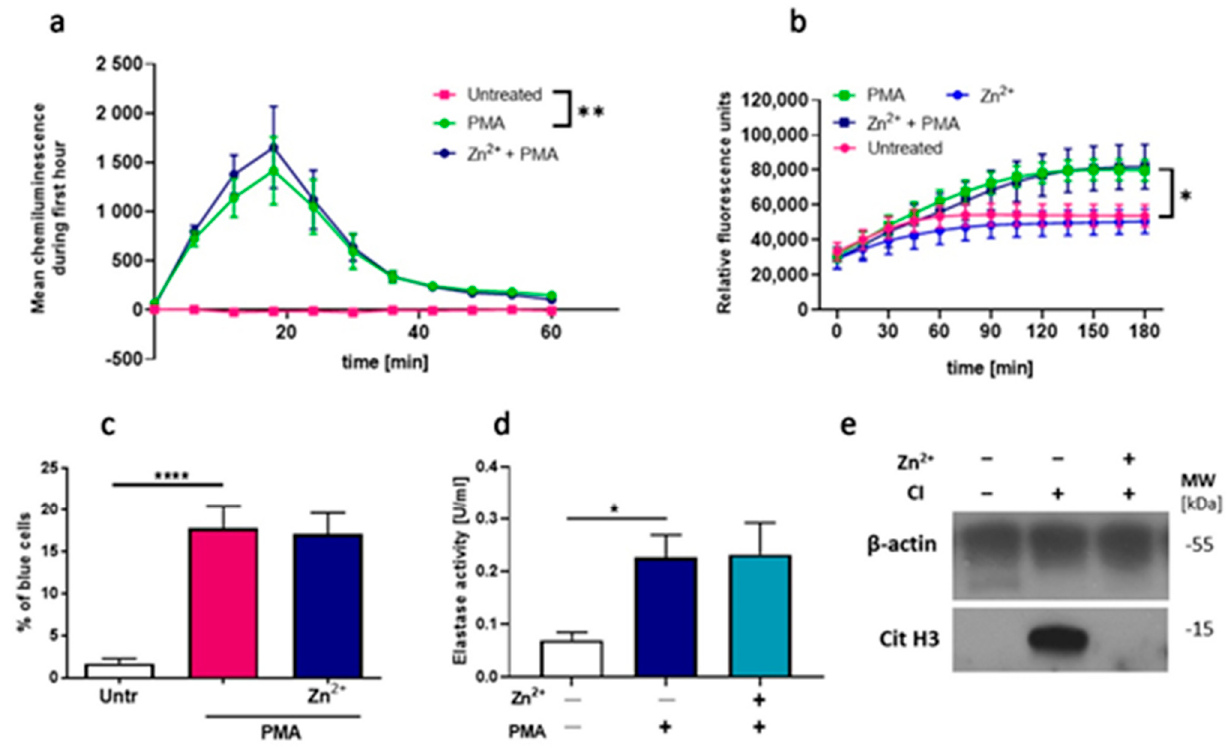
Figure 2. Zinc does not affect reactive oxygen species (ROS) release and neutrophil elastase (NE) activity but inhibits the citrullination of histone H3. Neutrophils were incubated with or without 10 µ M zinc and ( a ) 10 µ M luminol, ( b ) 4 µ g/mL dihydrorhodamine (DHR) 123 or ( c ) 2 mg/mL nitroblue tetrazolium (NBT). Next, cells were stimulated with ( a – d ) 100 nM PMA or ( e ) 4 µ M CI. Post stimulation, ( a ) chemiluminescence was measured; ( b ) fluorescence was analyzed; ( c ) the percentage of cells containing deposits of formazan was counted; ( d ) extracellular NE was washed away, NETs were digested to release NE from NETs, and NE activity was measured ( e ) immunodetection of citrullinated histone H3 was performed. One-way ANOVA with post hoc ( a , c ) Tukey’s test; ( d ) Dunnett’s test. ( b ) Two-way ANOVA with post hoc Dunnett’s test. The means ( a , b ) ± SEM; ( c , d ) + SEM are shown; ( a ) n = 3, ( b ) n = 6, ( c ) n = 9, ( d ) n = 7, ( e ) one representative out of 3 experiments from three different blood donors is shown; * ( p ≤ 0.05), ** ( p ≤ 0.01), **** ( p ≤ 0.0001).